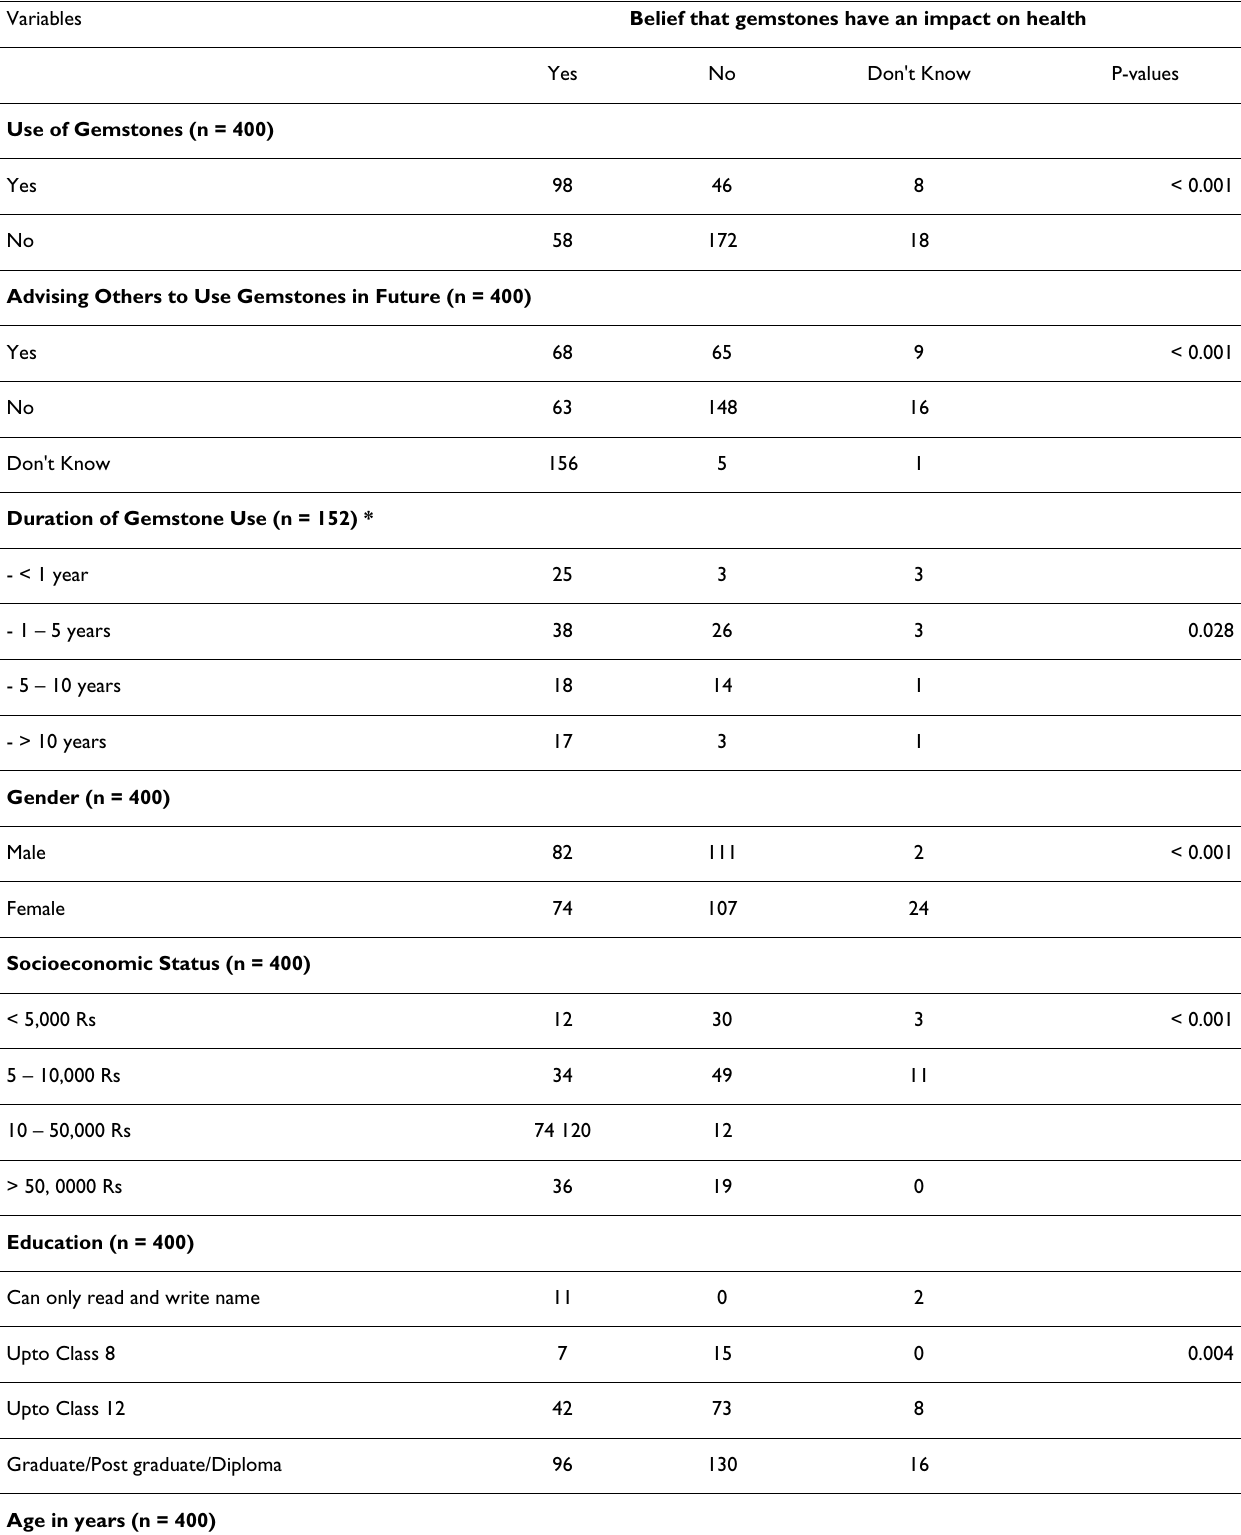
Table 4: Associations of belief that gemstones have an impact on health Variables Belief that gemstones have an impact on health Yes No Don't Know P-values Use of Gemstones (n = 400)